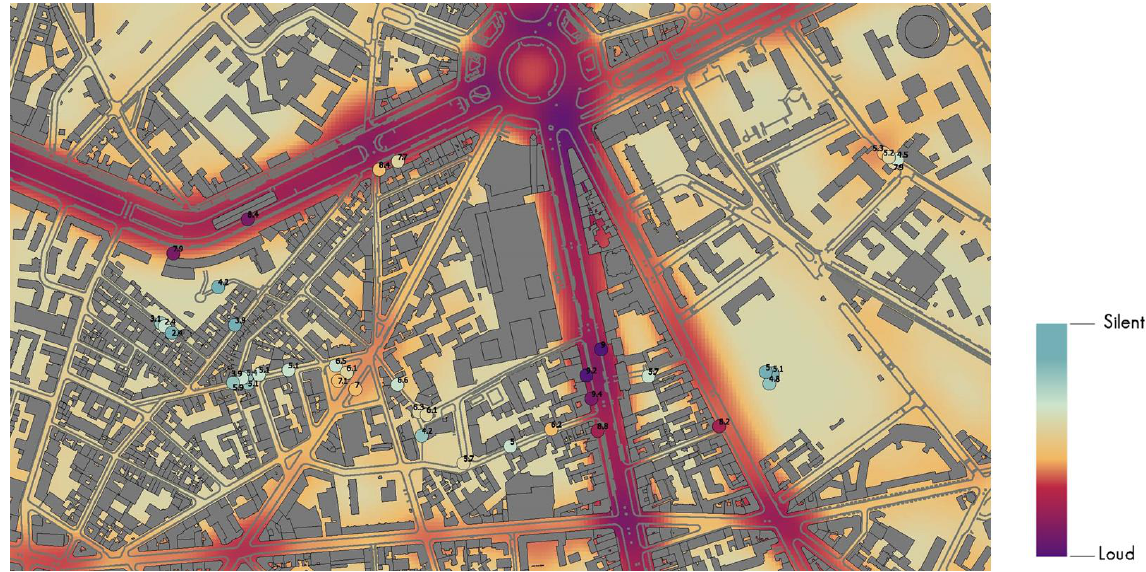
Figure 15: Mapping of loudness modelled on open and closed spaces (Eq. 5).The circles represent the mean values of perceived loudness evaluated by participants.